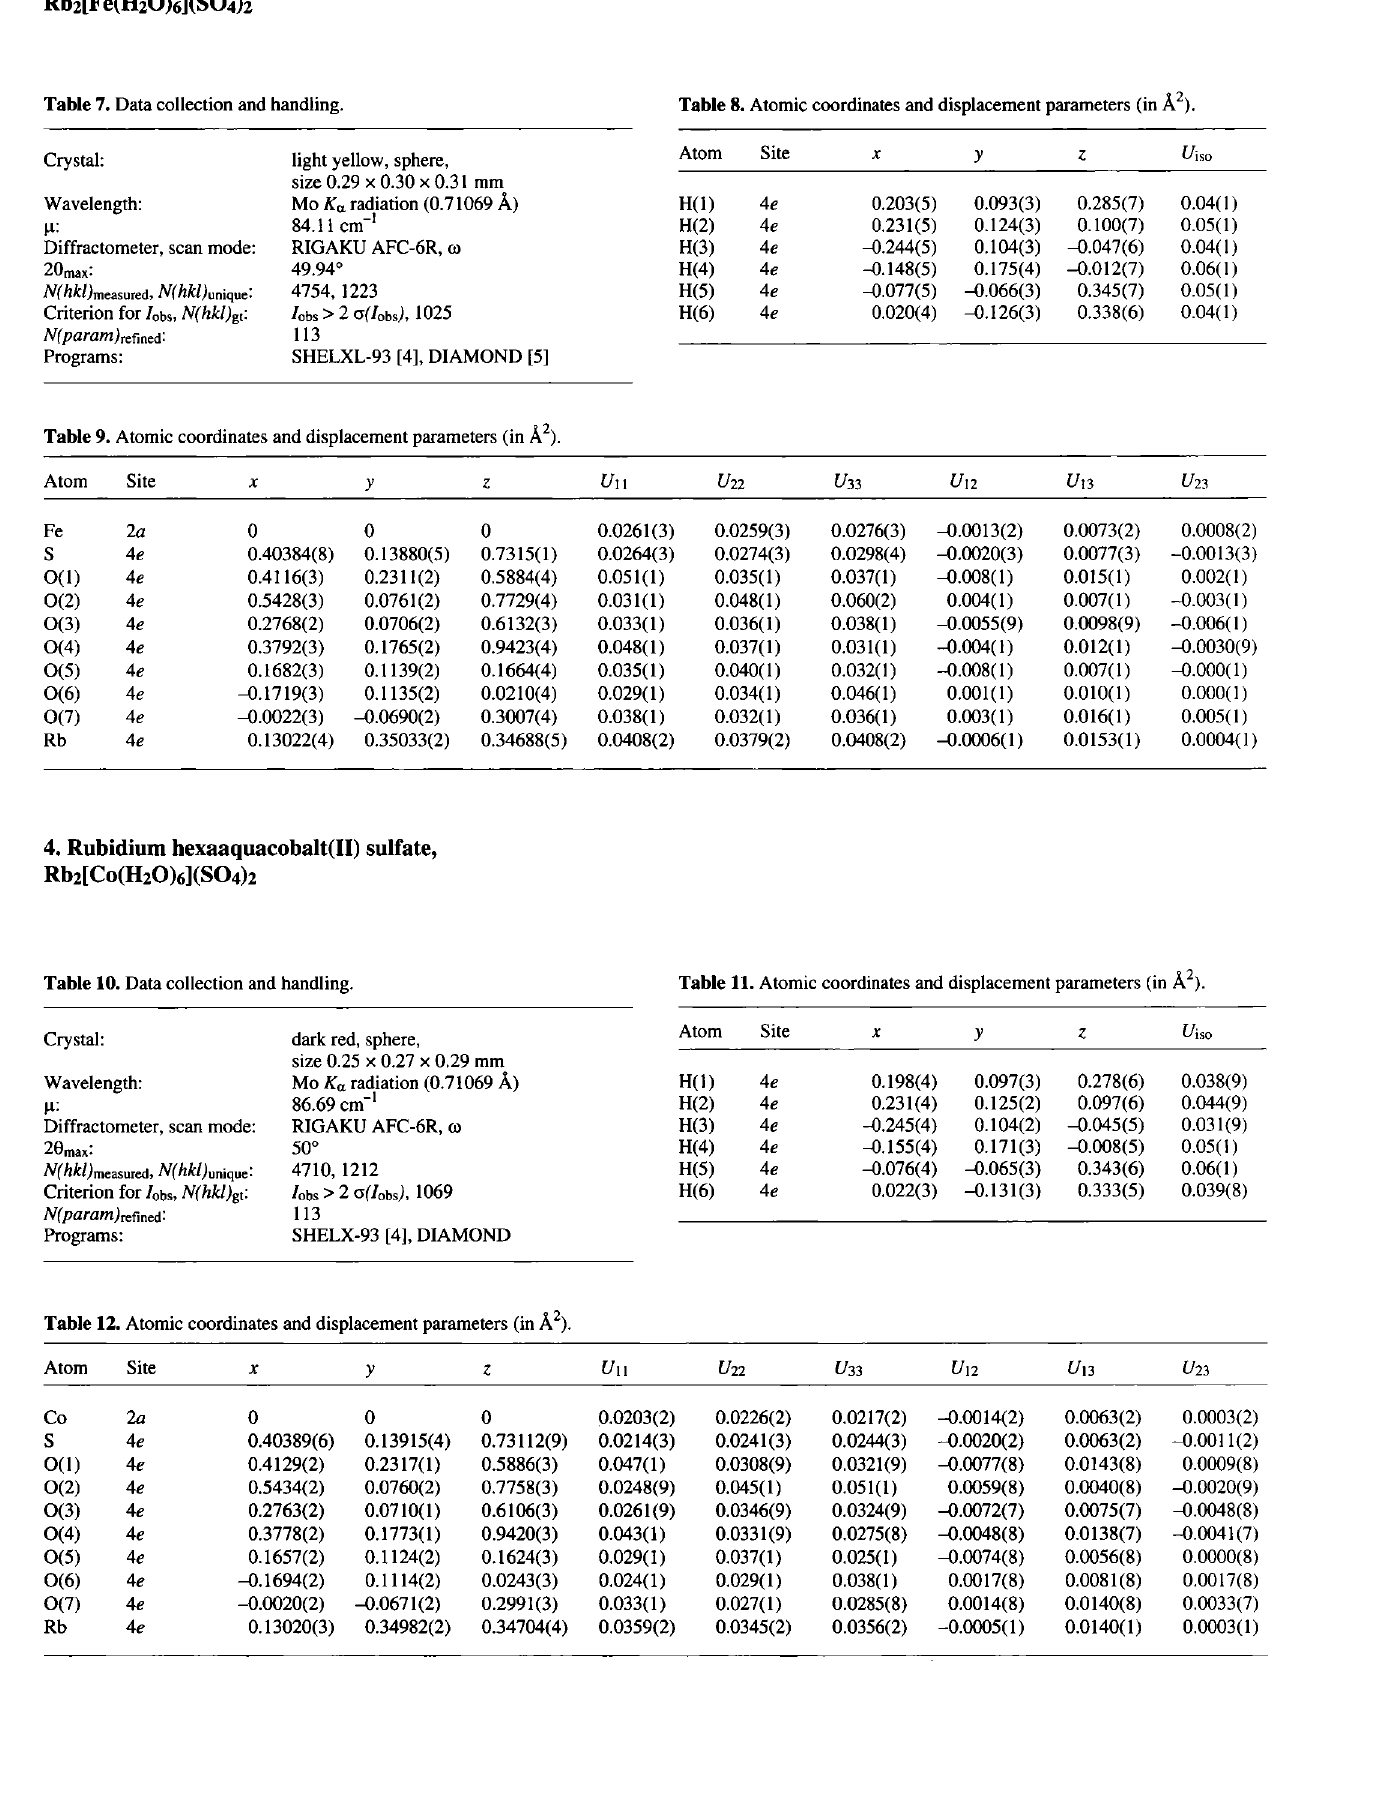
Table 7. Data collection and handling. Table 8. Atomic coordinates and displacement parameters (in A 2 ).